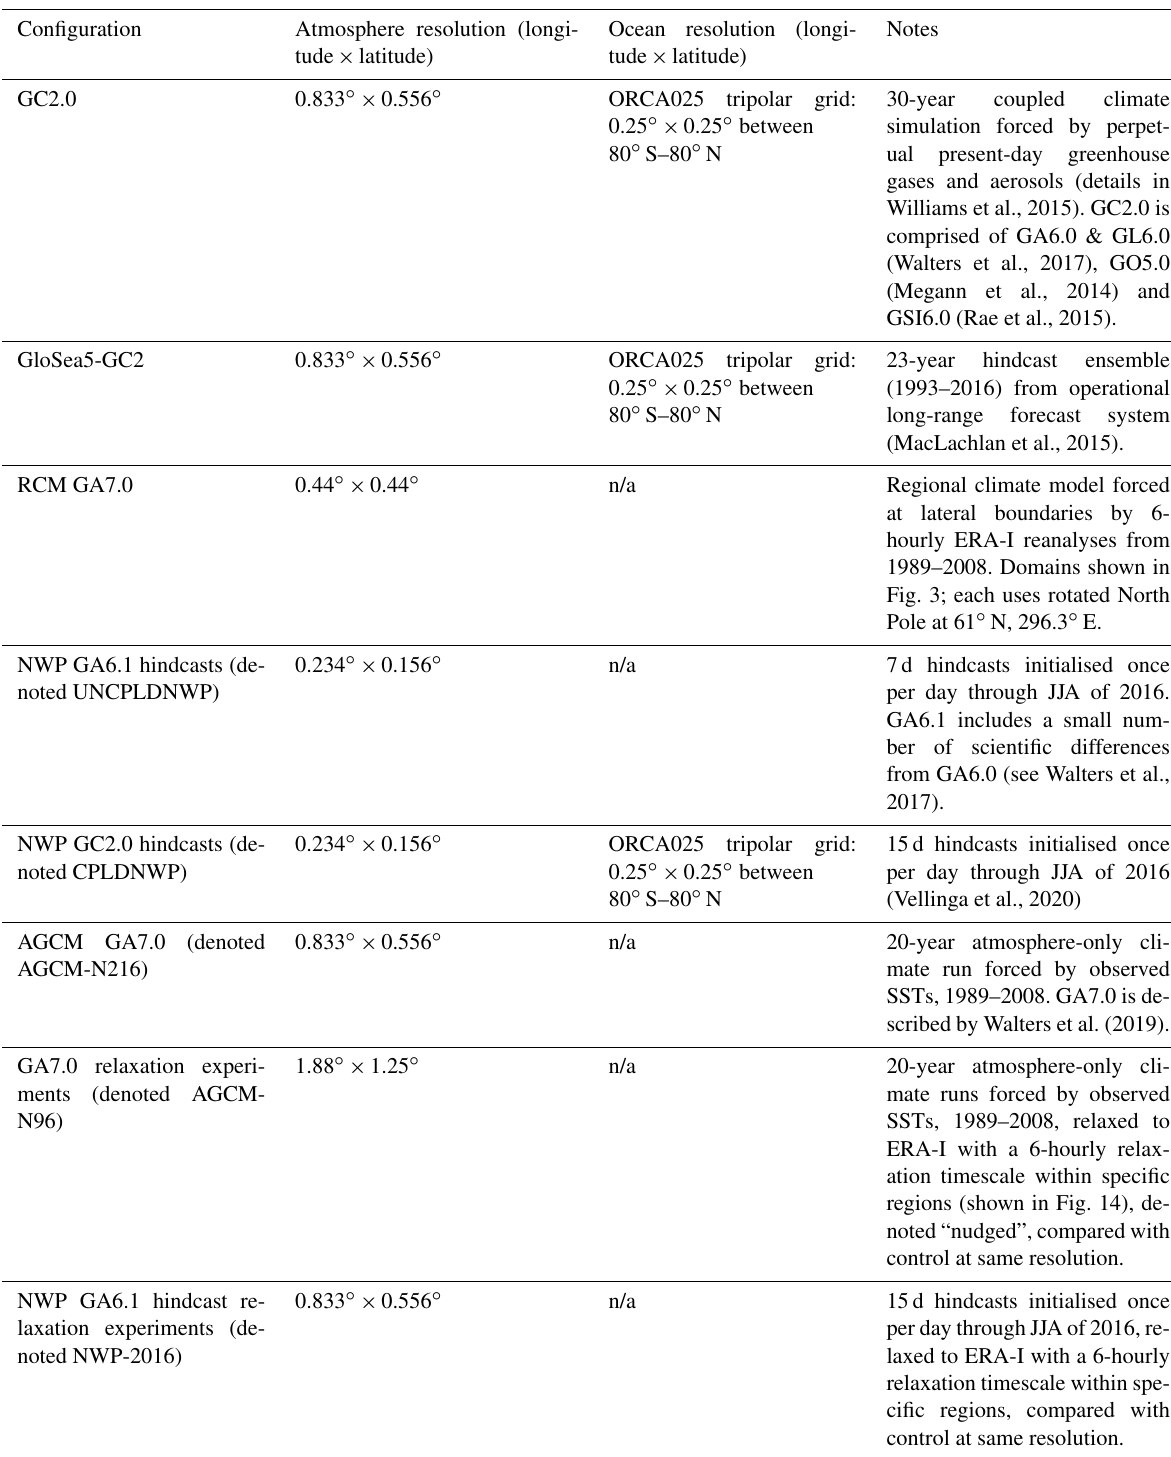
Table 1. Model configurations used in this